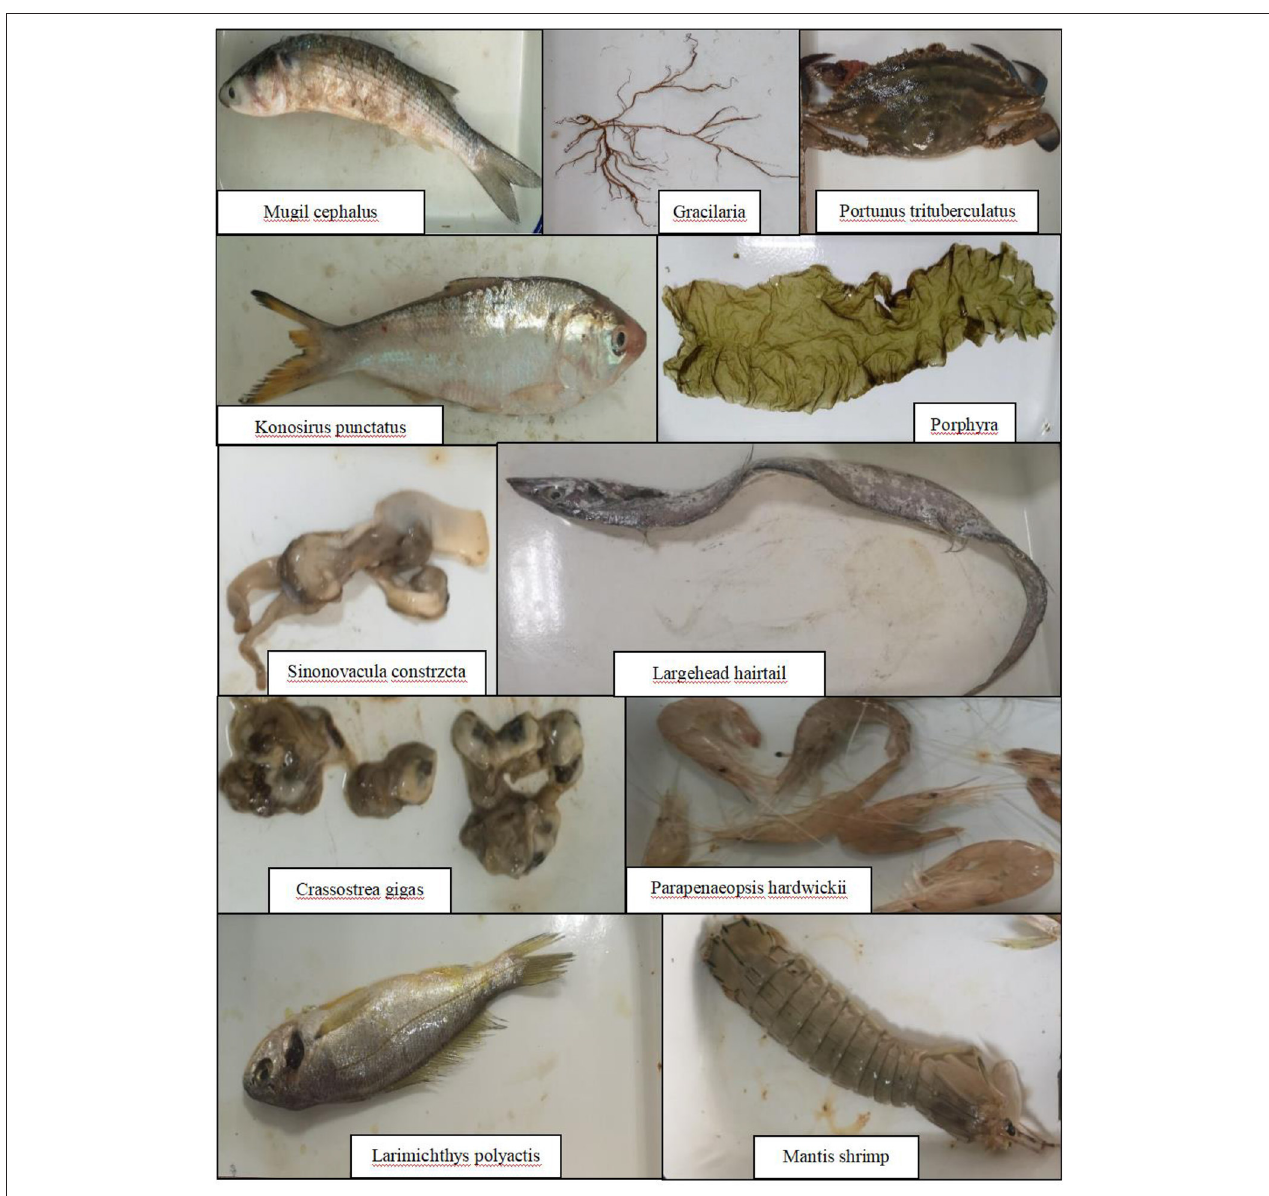
FIGURE 2 | Specimens of the marine organism sampled in this